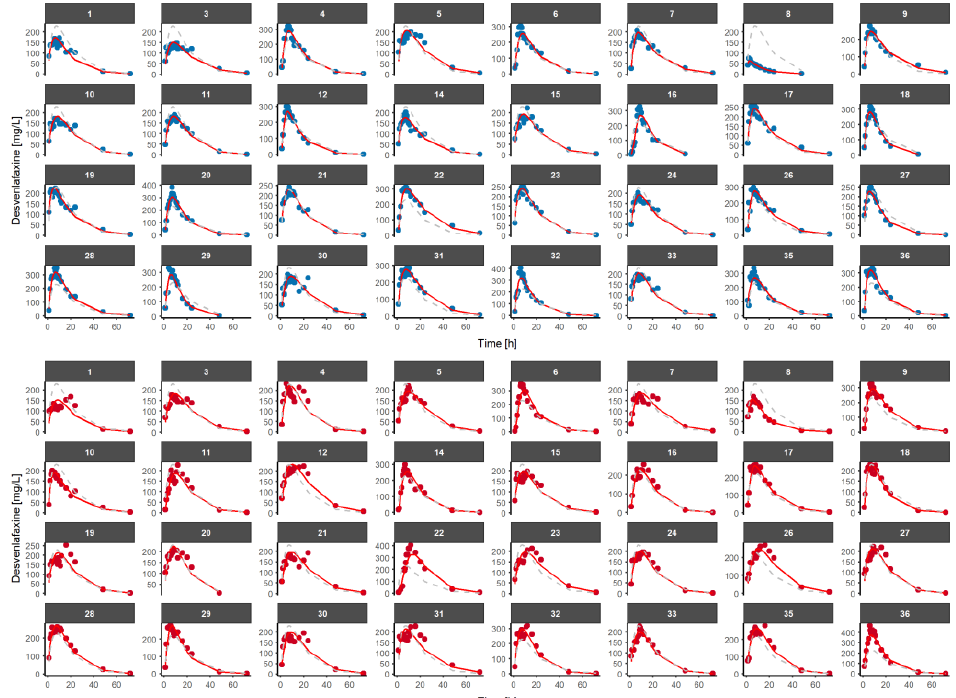
Figure 2. Individual predicted plots of the final population pharmacokinetic model of desvenlafaxine after the administration of a single dose of 100 mg of desvenlafaxine prolonged-release tablets to healthy volunteers in a fasted state. Blue dots represent desvenlafaxine observations from the Reference formulation and red dots represent desvenlafaxine observations from the Test formulation. Red line represents the individual predicted concentrations. Dashed grey line represents the population predicted concentrations.